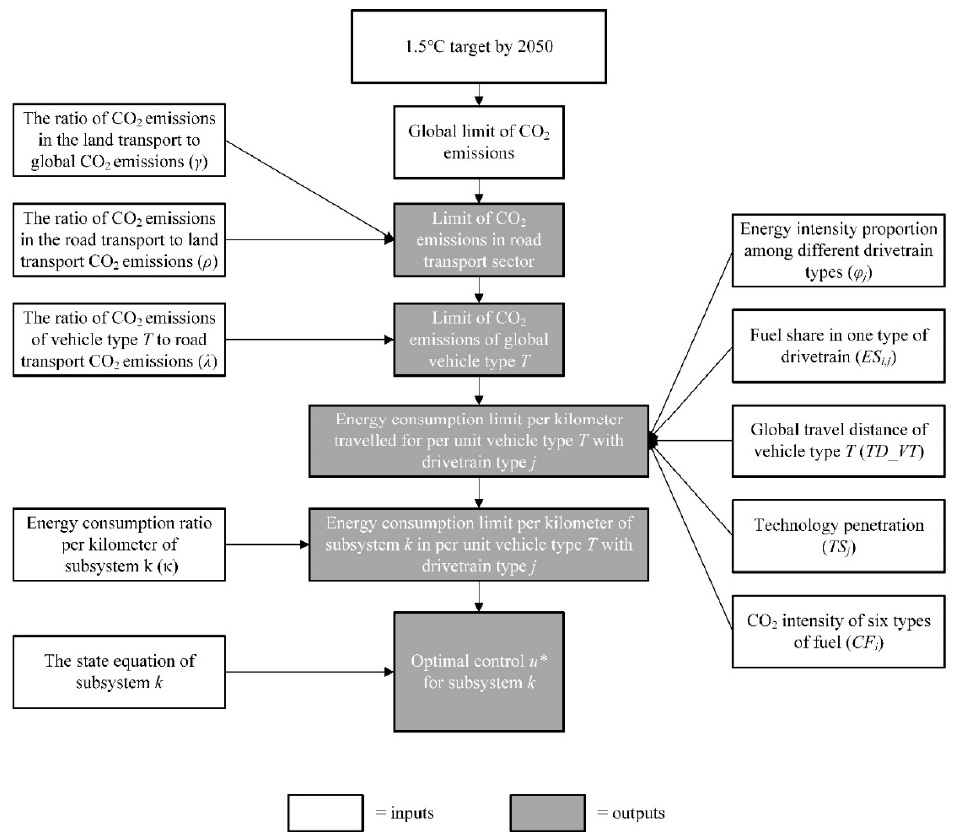
Figure 1. Framework of optimal control design for meeting the 1.5 °C target.